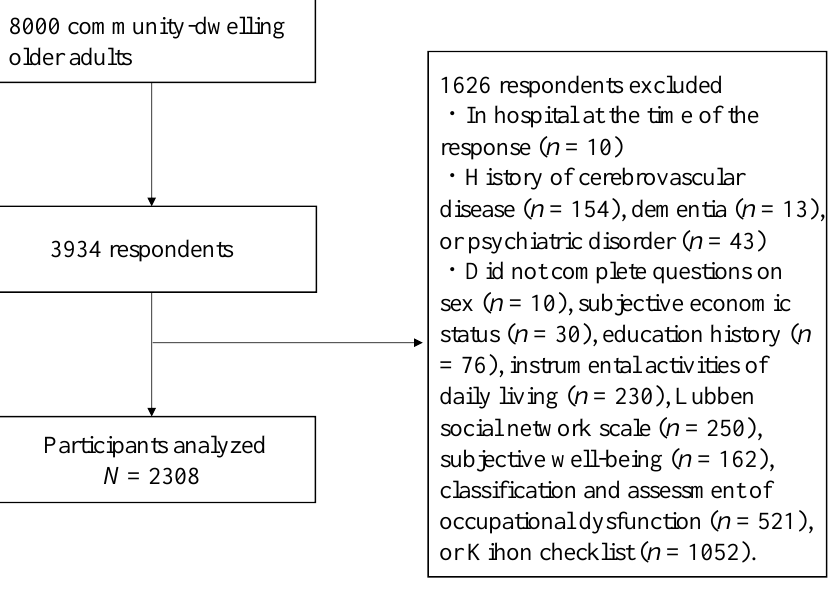
Figure 1. Participant flowchart.